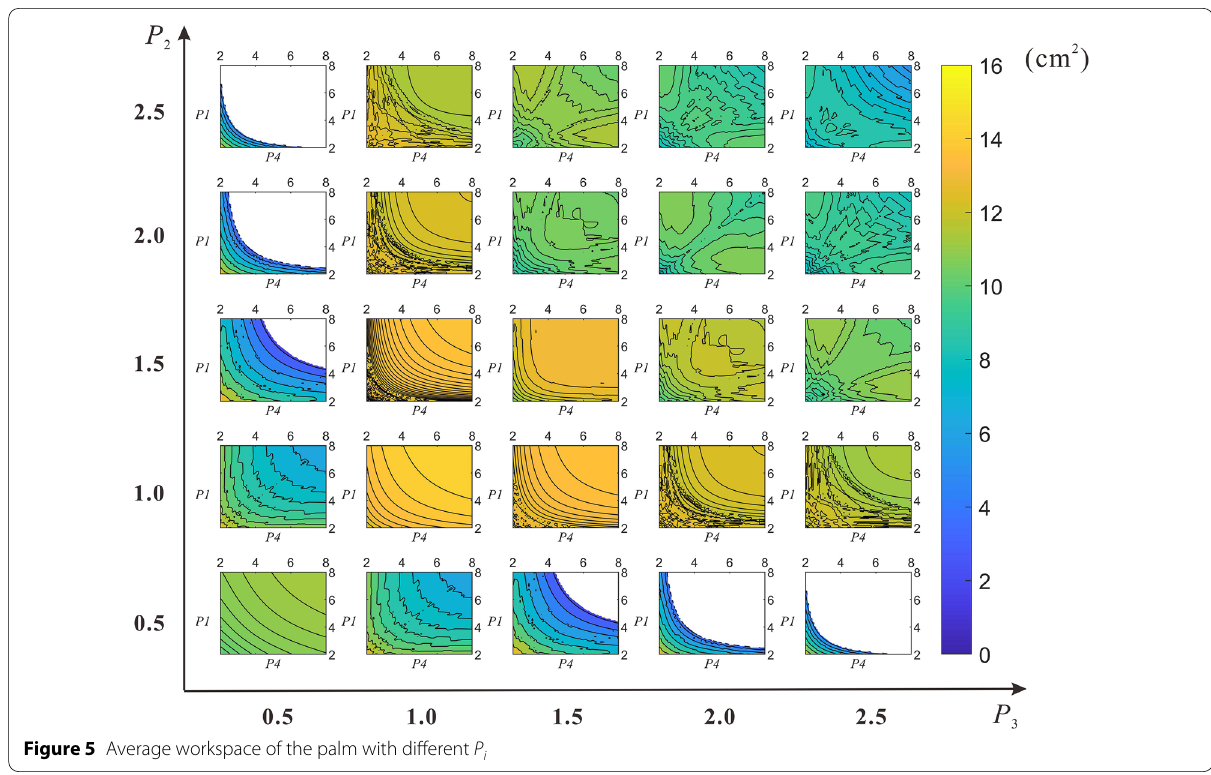
Figure 5 Average workspace of the palm with different P i